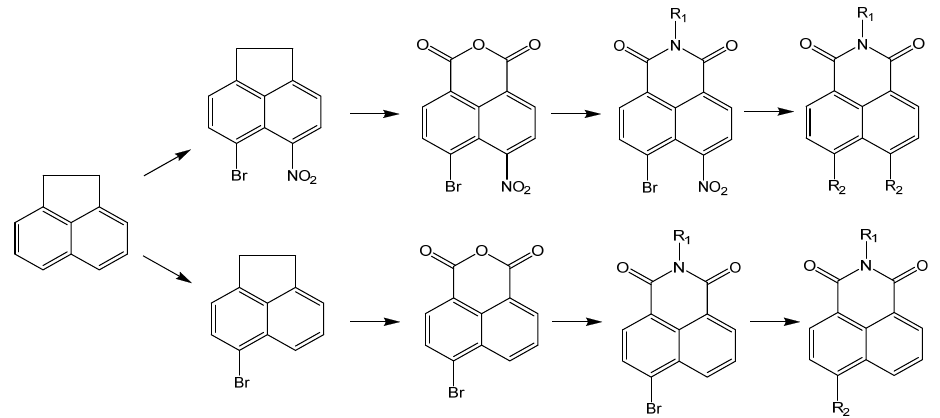
Scheme 1. Generic pathways for the synthesis of